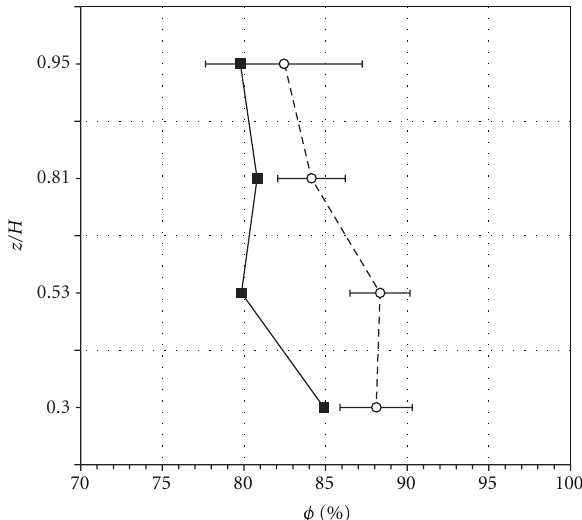
Figure 4: Comparative profiles of air-relative humidity, φ ( y / W = 0.38, z / H ) [%] (see CSML in Figure 1(b)). (Legend: numerical: (cid:2) ; experimental: (cid:6) ).